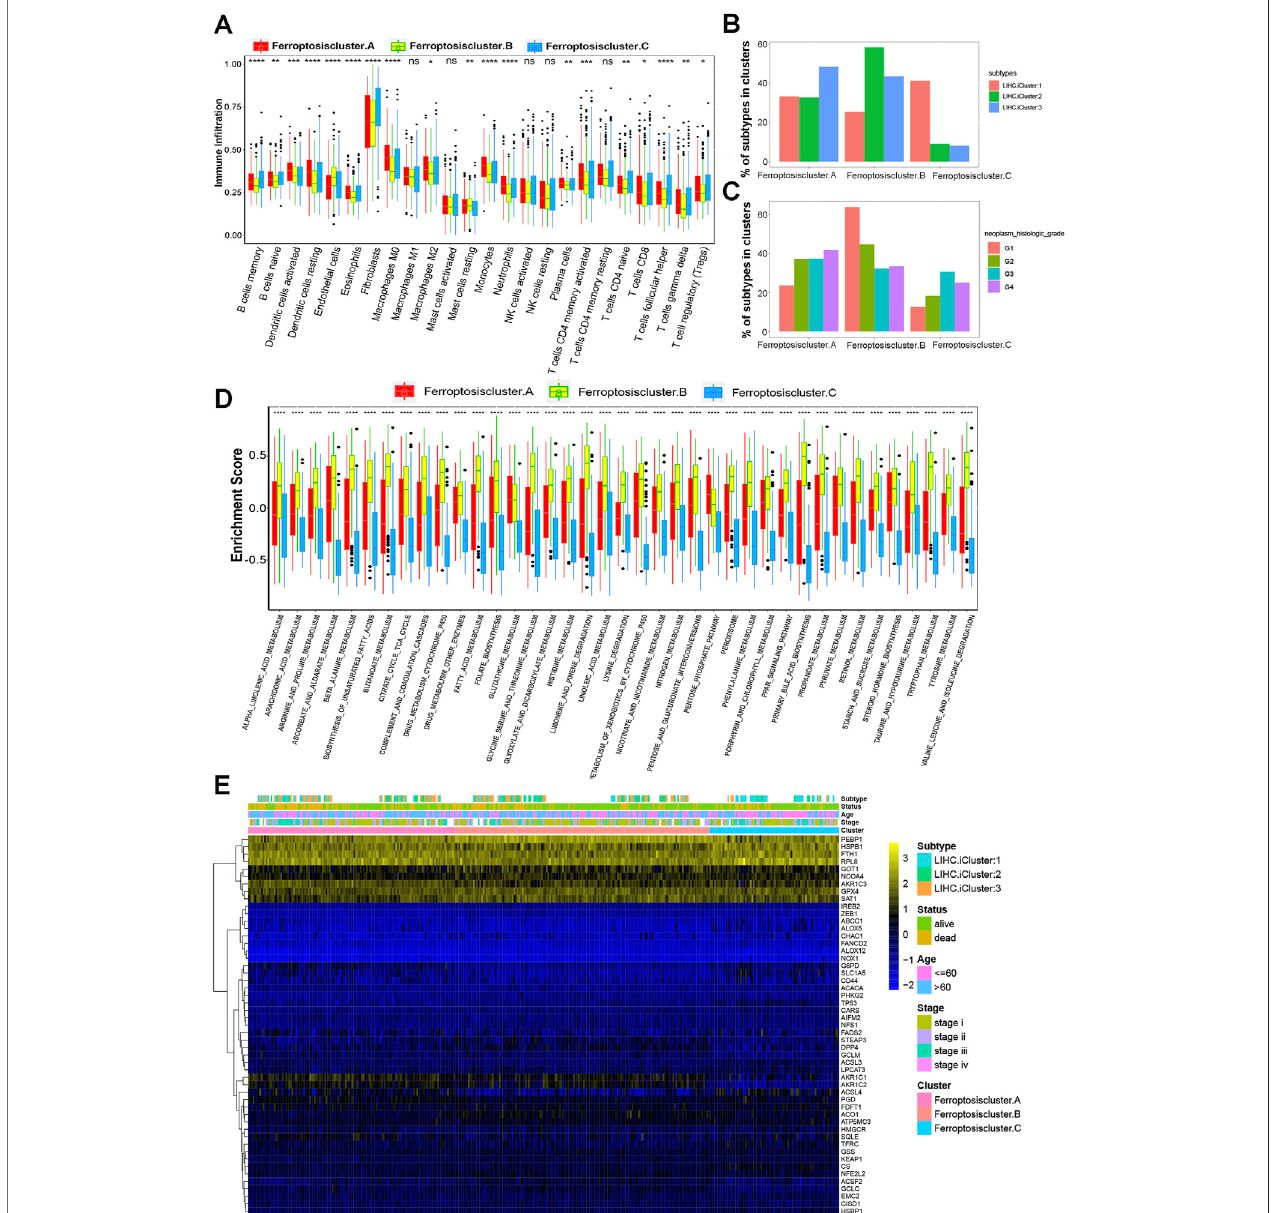
FIGURE3| TMEcellin fi ltrationcharacteristicsindistinctferroptosismodi fi cationpatterns. (A) Theabundancesof24immunein fi ltratingcellsubpopulationsinthree ferroptosis modi fi cation patterns. (B,C) Correlations between ferroptosis modi fi cation patterns and clinicopathologic characteristics of HCC patients. (B) LIHC iCluster; (C) histologic grade. (D) GSVA enrichment pathways in three different ferroptosis subgroups using variance analysis. (E) Unsupervised clustering of 51 ferroptosis regulators in three ferroptosis modi fi cation subgroups of HCC.